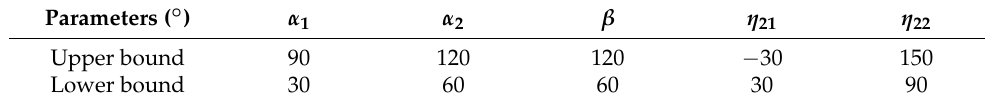
Table 1. The upper and lower bounds of the design parameters.